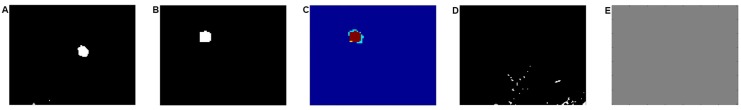
Illustration of an invasive ductal carcinoma (case I).(A)-(E) Segmented tumours using FCMs and the proposed hybrid classification, overlapping images, and depiction of noisy voxels from imaged fatty tissue, using both classification methods; absence of noisy voxels in E relate to results from the proposed algorithm.